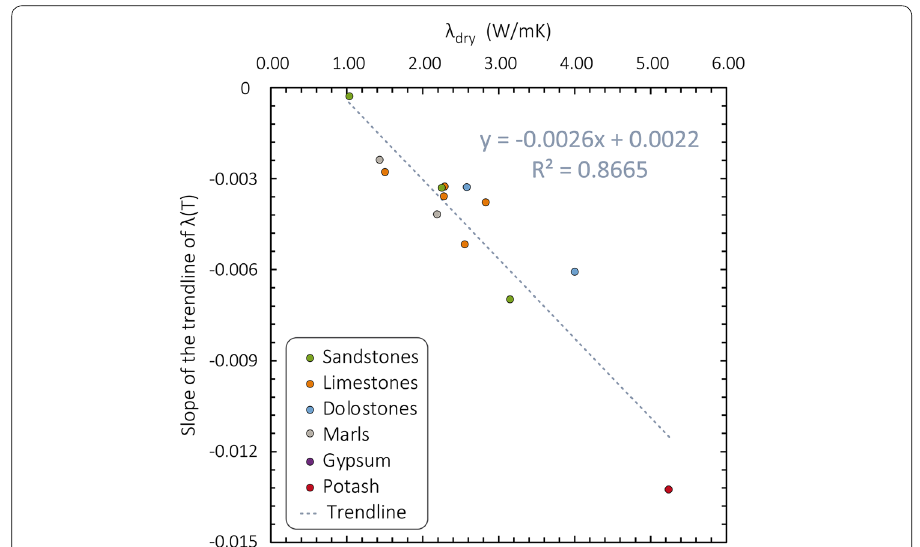
Fig. 9 Slope of the trendlines of dry thermal conductivity as a function of temperature (see Fig. 8, equations in Additional file 2) as a function of thermal conductivity of the corresponding sample in the dry state at ambient temperature ( λ dry ). Trendline and corresponding coefficient of determination, R 2 , are represented. Colors correspond to lithologies. Equation of the trendline is used to estimate thermal conductivity at a given temperature from dry conductivity of the